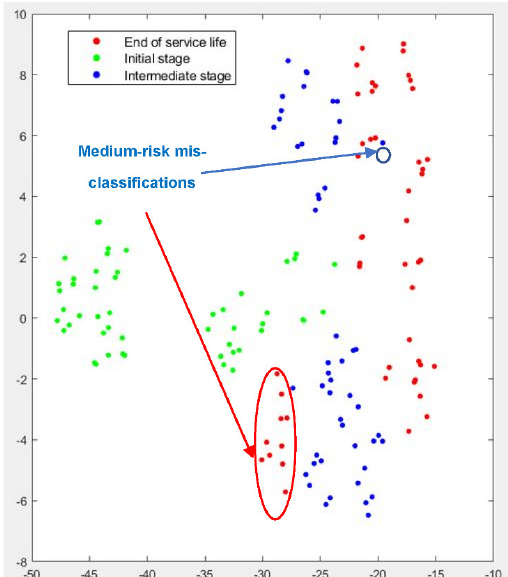
Figure 9. Graphical results of t-SNE dimensionality reduction for Test No. 2.